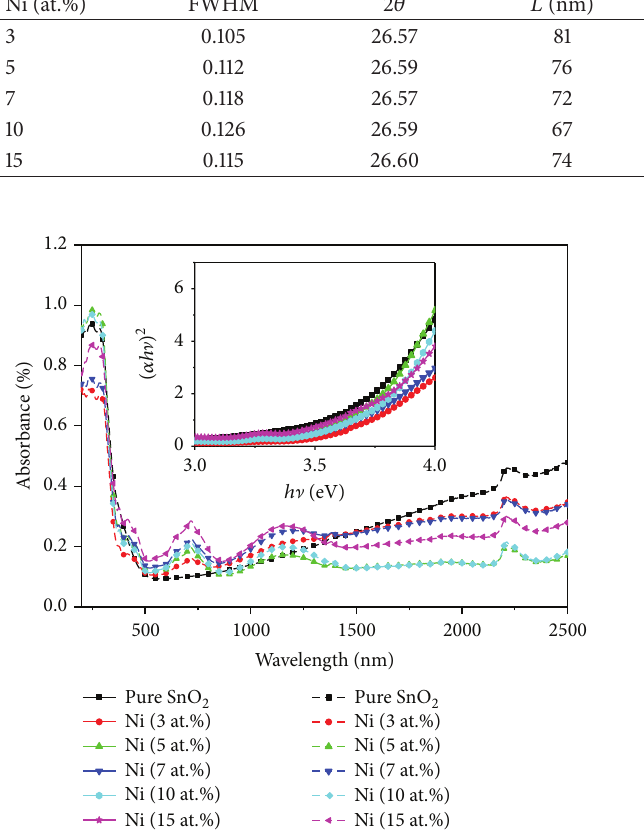
Figure 2: Optical absorbance spectra of Ni doped SnO 2 powder samples. Inset figure shows the optical band gaps of the Ni doped SnO 2 powder samples.